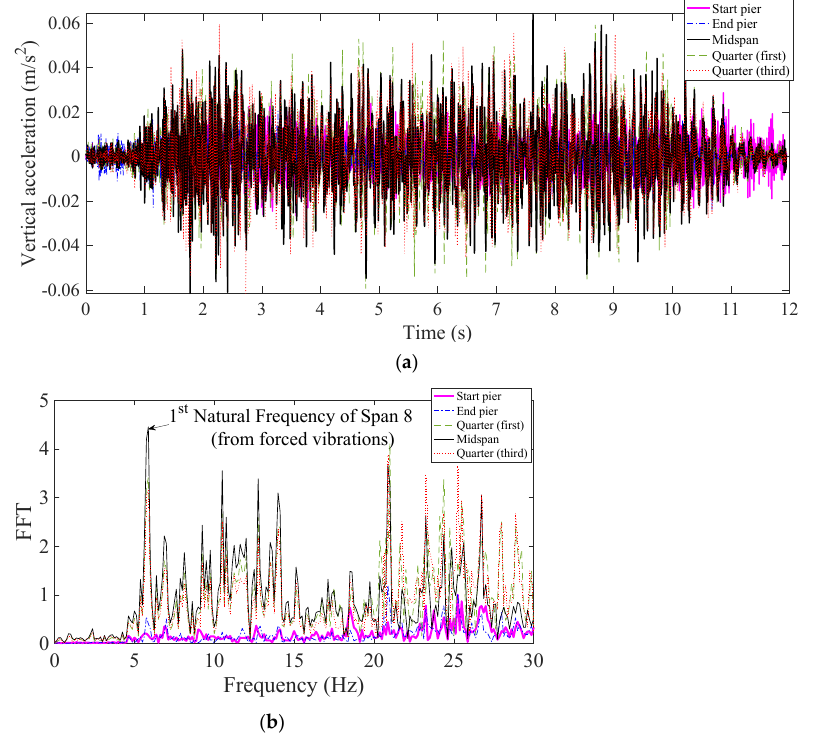
Figure 5. Forced − vibration response of Span 8: ( a ) in time domain, and ( b ) in frequency domain. Figure 5. Forced-vibration response of Span 8: ( a ) in time domain, and ( b ) in frequency Table 1. The 1st Natural Frequencies of each span.